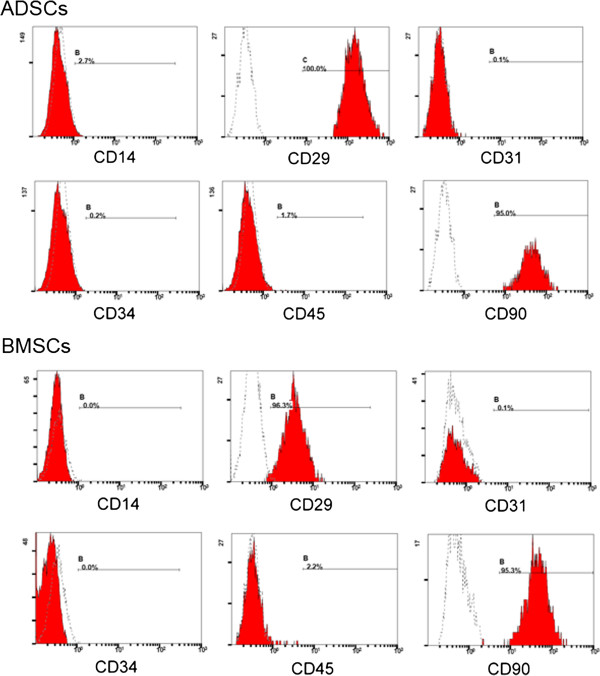
Identification of adipose-derived stem cells (ADSCs) and bone marrow mesenchymal stem cells (BMSCs) with flow cytometry. Flow cytometry revealed that the distribution of ADSCs and BMSCs that stained for CD14, CD31, CD34, and CD45 (shaded regions) did not differ from that of the isotype control (open regions). The majority of cells positively stained for CD29 and CD90 (shaded regions) compared with the isotype control cells (open regions).